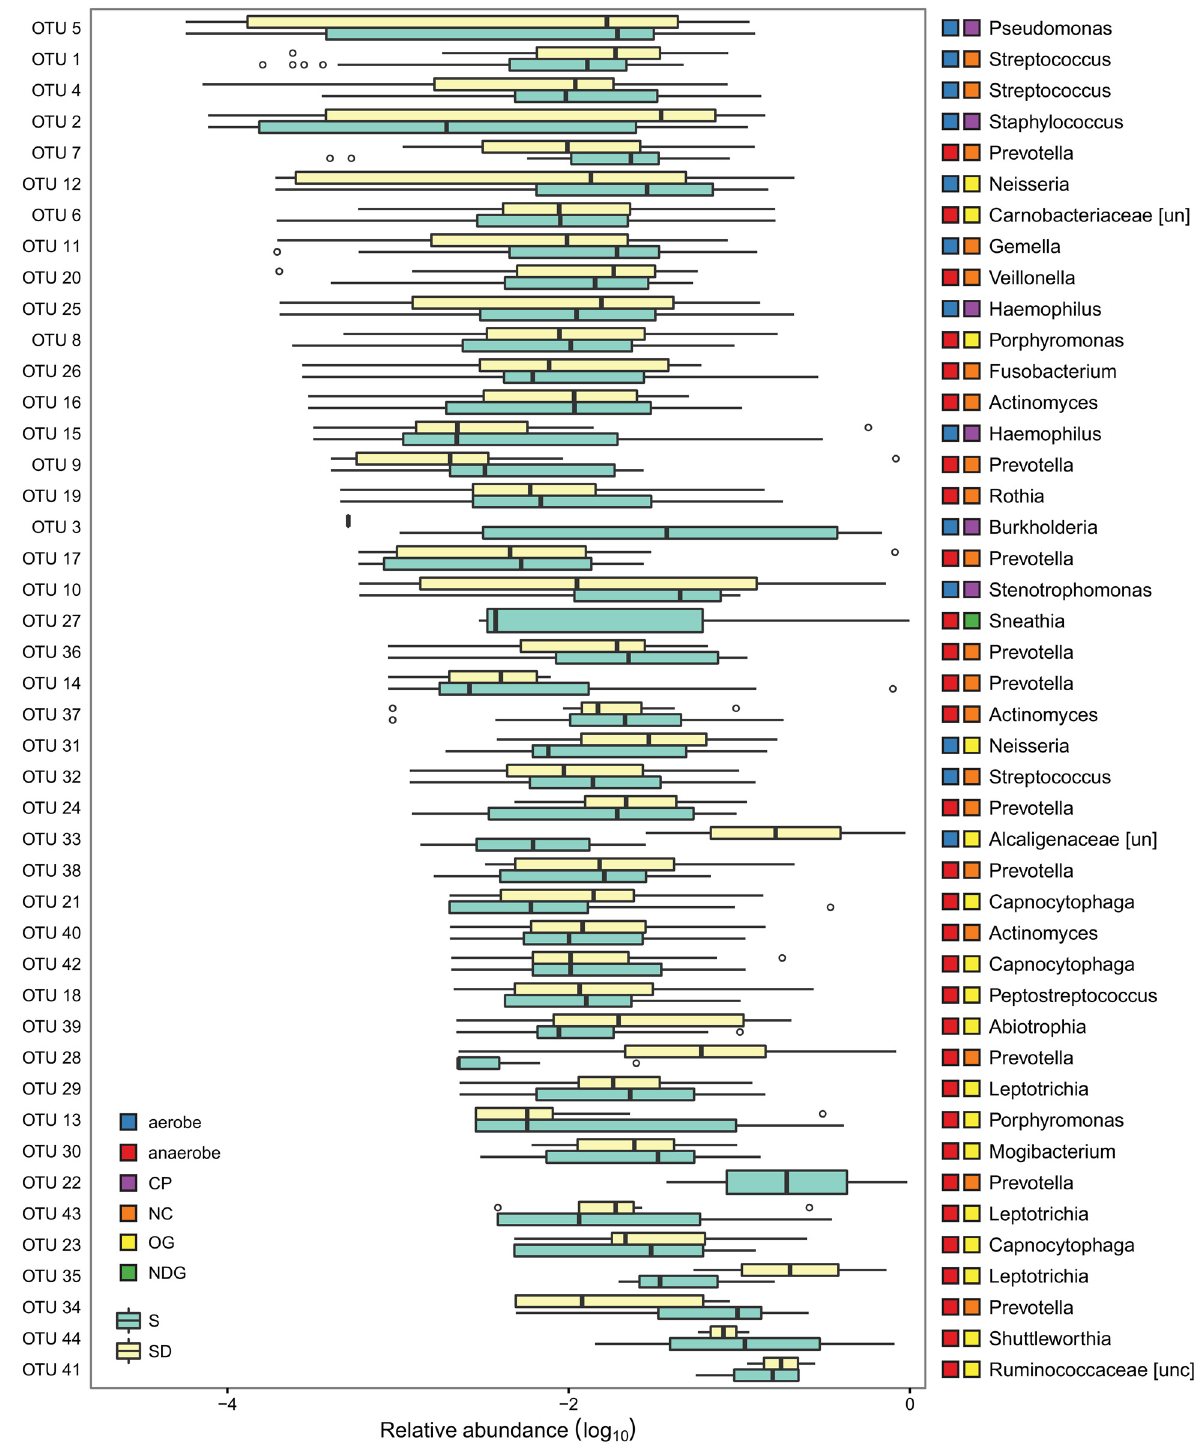
Fig 1. Relative abundance of sputum microbiota among patients. Relative OTUs abundance was computed dividing the number of 16S sequences assigned to each OTU by the total number of sequences obtained for each sample. Boxes denote the interquartile range (IQR) between the 25 th and the 75 th percentile (first and third quartiles), whereas the inner line represents the median. Whiskers represent the lowest and highest values within 1.5 times IQR from the first and third quartiles Outliers were reported using white circles. CP: common CF pathogens; NC: non-classical but commonly identified genera in CF; OG: other genera in CF; NDG: not yet described genera in CF; S: stable patients; SD: severe decliner patients; [un] unclassified; [unc] uncultured.